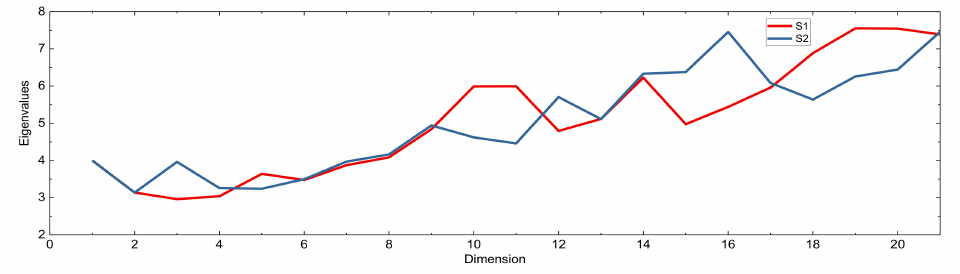
Figure 5. Example of the Eigenvalues of the covariance matrix after Z transformation of S1 and S2 for Baseline